Question: Describe this figure in one sentence.
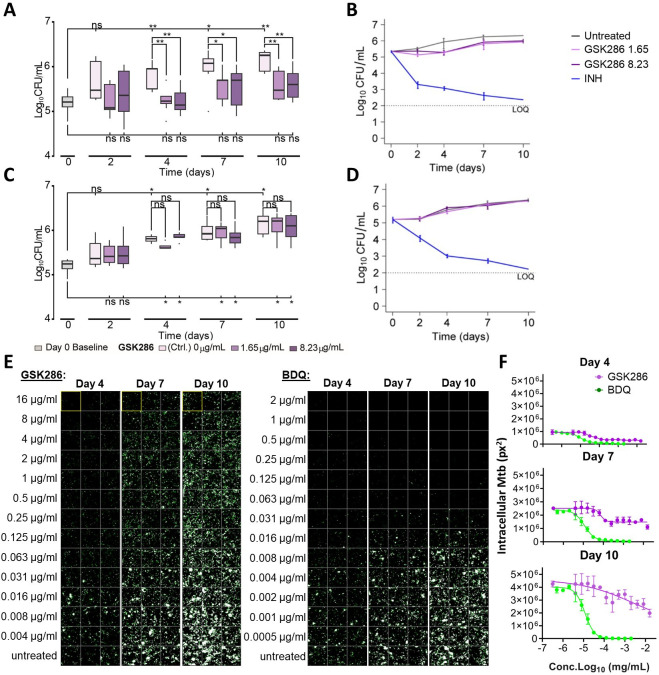
Answer: Intracellular activity of GSK286 against Mtb. The activity of GSK286 at 1.65 µg/mL and 8.23 µg/mL against the Mtb Erdman wild-type ( A and B ) and Mtb EM19 (resistant Rv1625c mutant) ( C and D ) strains was measured intracellularly in infected macrophages derived from human CD14 + monocytes over a period of 10 days. Two-way ANOVA and post hoc Wilcoxon test (non-parametric) with Benjamini-Hochberg correction were performed for statistical analyses. ns, not significant, * = P < 0.05; ** = P < 0.01. ( E ) Confocal microscopy images at days 4, 7, and 10 post-treatment of intracellular Mtb H37Rv-GFP infecting THP-1 macrophages and treated with increasing concentrations of GSK286. BDQ is used as a positive control. ( F ) Quantification of the bacterial burden based on pixel intensity (px²) relative to log 10 drug concentration at days 4, 7, and 10 post-treatment.